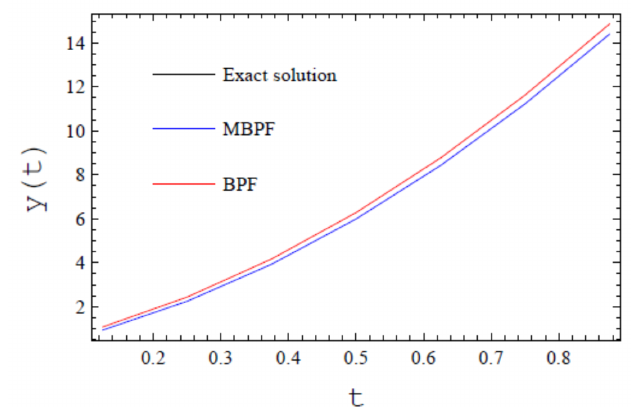
Figure 1. The absolute error of IBPFs and BPFs expansions comparison at the midpoints of the intervals of IBPFs.